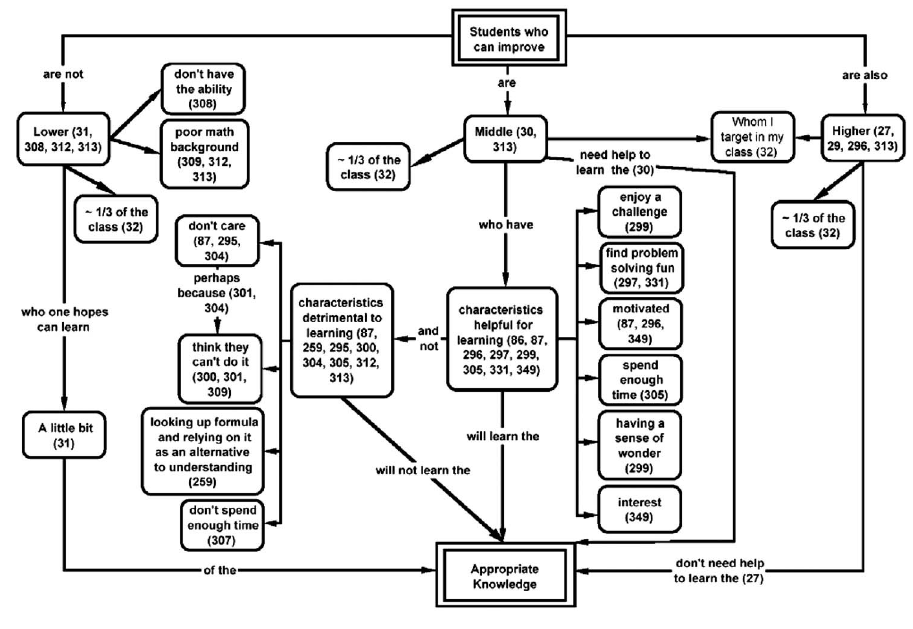
FIG. 2. Child map of instruc- tor 6 for the principal category of “Students Who Can Improve.” The numbers in parentheses are statement numbers from the tran- script of this instructor that justi- fies the existence of this